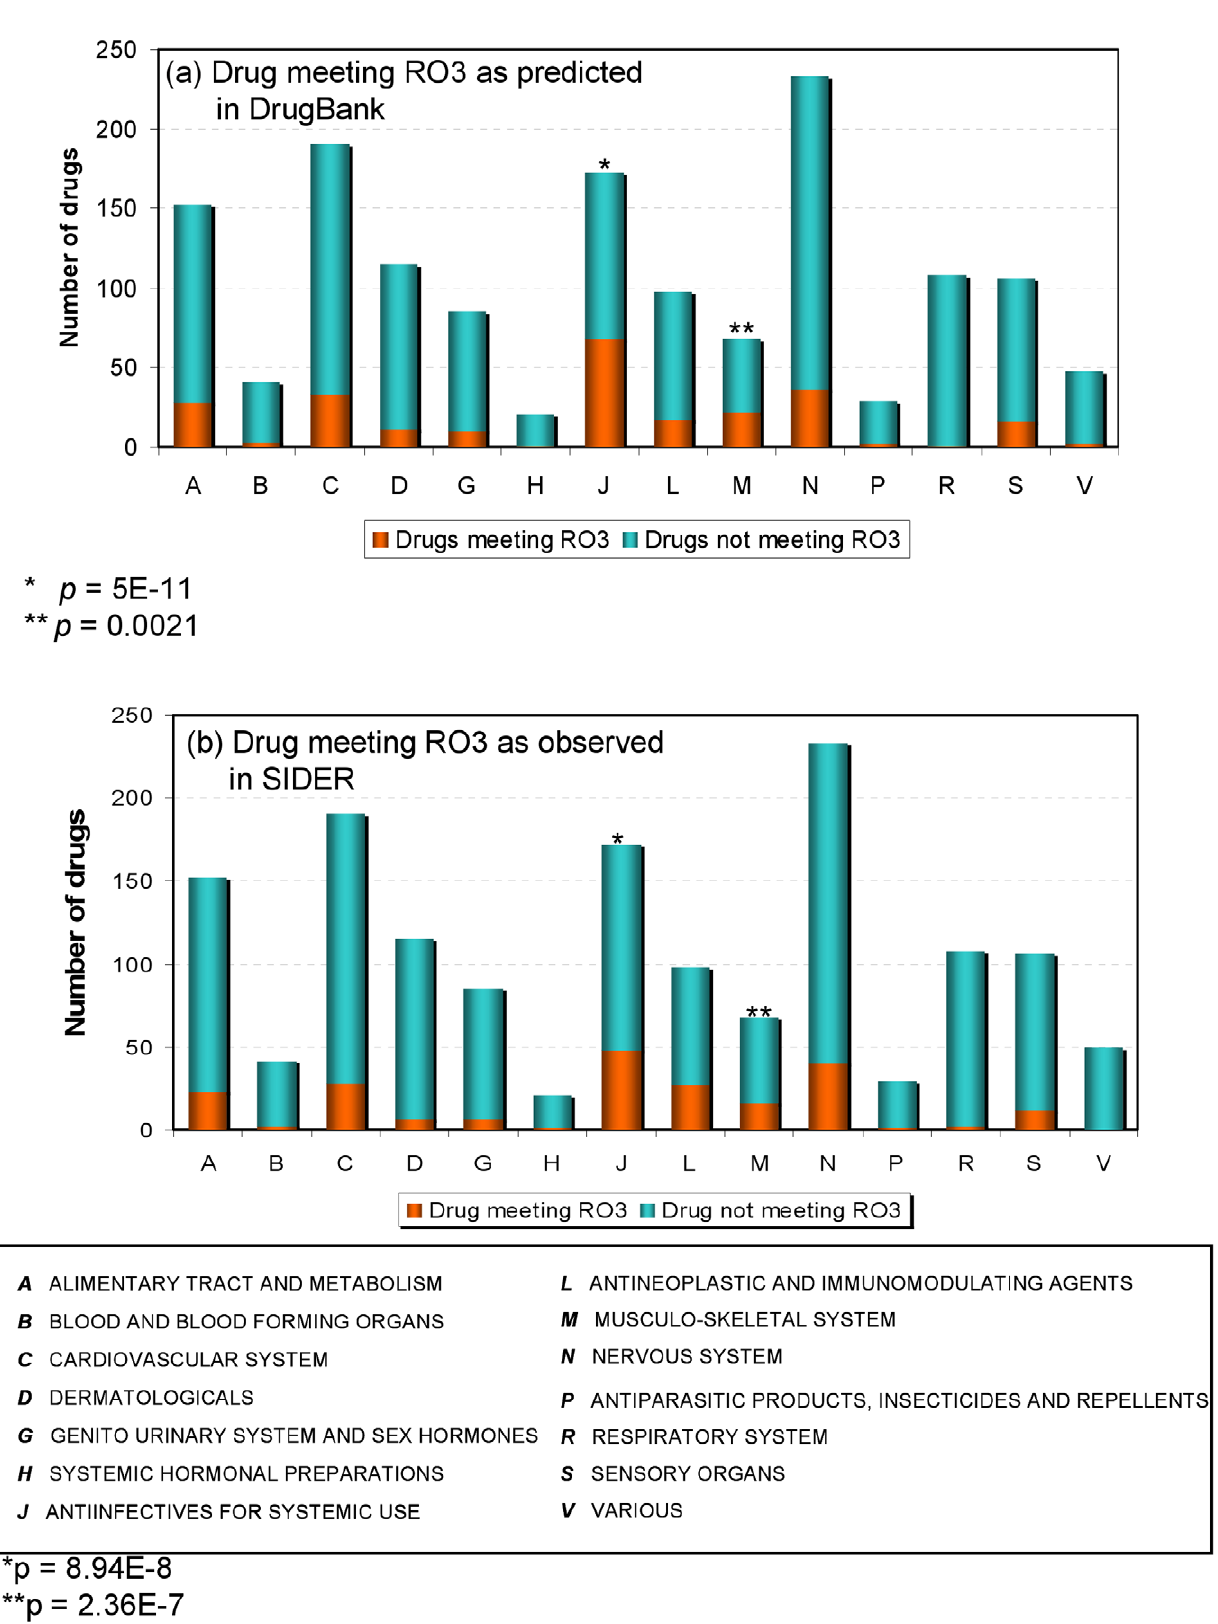
Figure 4. The distribution of small molecular drugs in (a) DrugBank and (b) SIDER that satisfy the ‘‘Rule of Three’’ (RO3) at the first level of Anatomical Therapeutic Chemical Classification System (ATC). The probability of the presence of DILI drugs is statistically significant in two therapeutic categories (J and M). doi:10.1371/journal.pcbi.1002310.g004 PLoS Computational Biology |